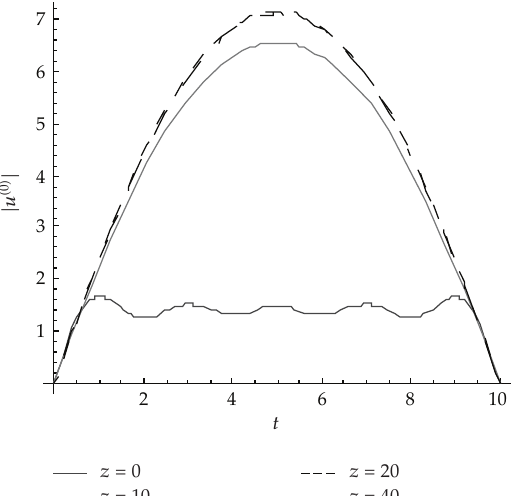
Figure 23: The zero-order approximation | u (cid:3) 0 (cid:4) | at α (cid:8) 1, T (cid:8) 10, γ (cid:8) 02 for di ff erent values of z , considering only one term in the series (cid:3) M (cid:8) 1 (cid:4)